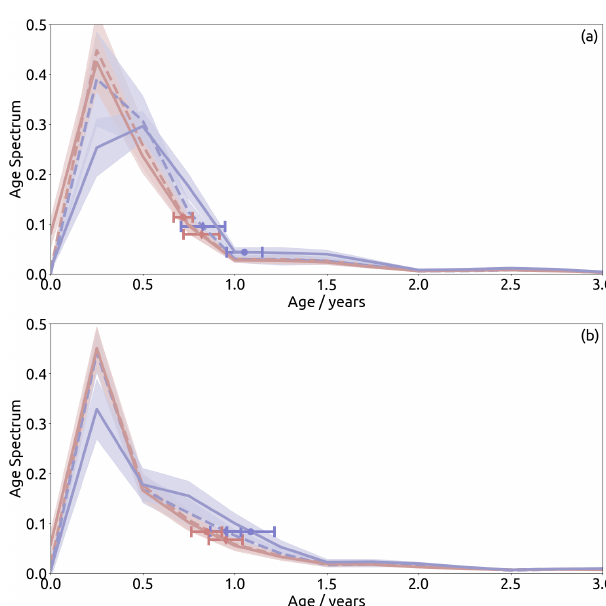
Figure 10. Age spectra from the results of EMAC-FFSL (red) and EMAC-CLaMS (blue) within the summertime lowermost strato- sphere regions of the eave structures at 360K (sold lines) and 400K (dashed lines) in (a) the Northern Hemisphere (55–75 ◦ N, July) and (b) the Southern Hemisphere (55–75 ◦ S,